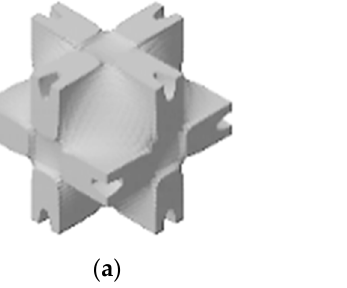
Figure 1. ( a ) The basic cell of the Neovius structure and ( b ) the complete Neovious